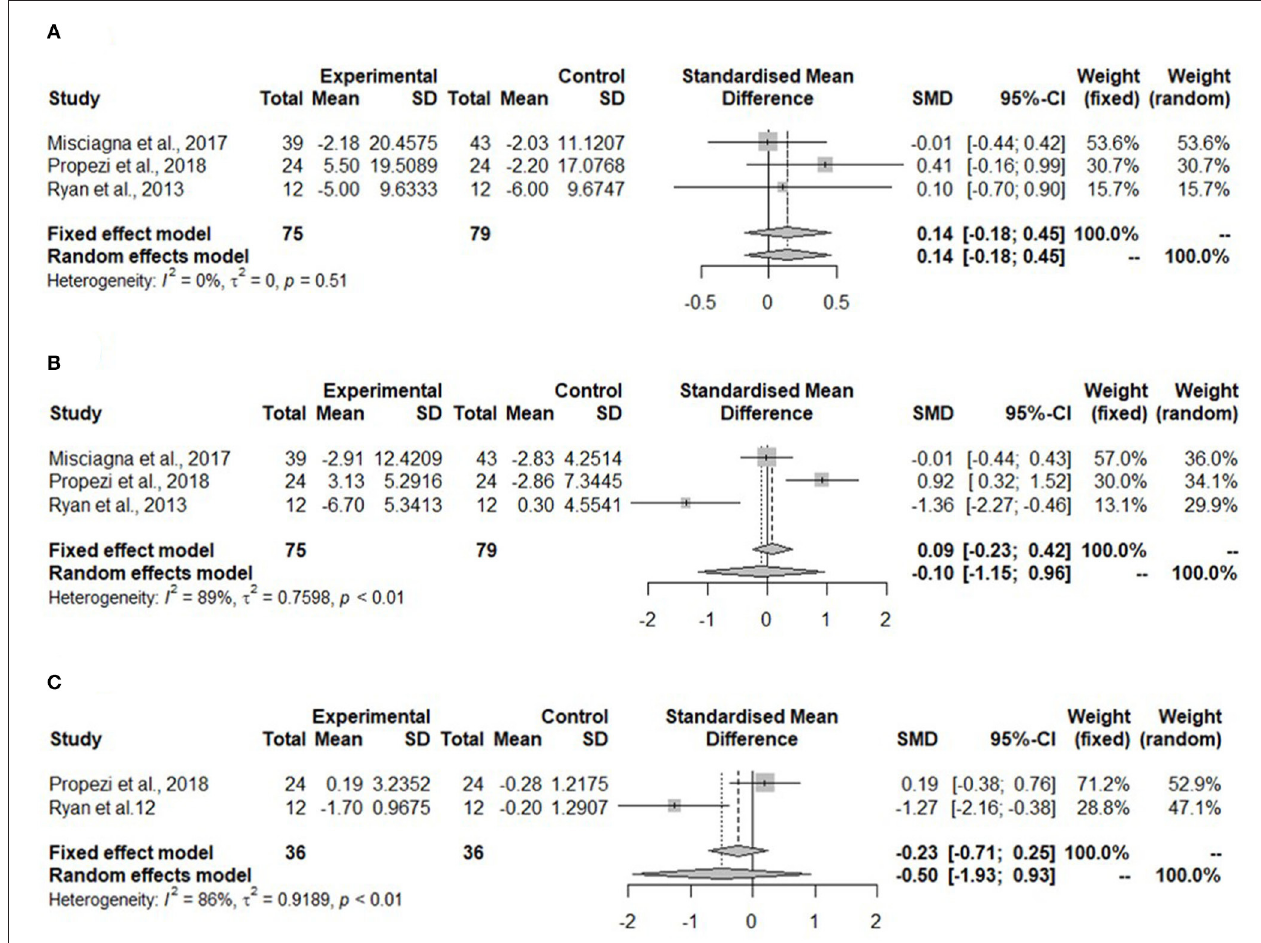
FIGURE 4 | Forest plots of (A) fasting glucose in isocaloric diet; (B) fasting insulin in isocaloric diet; (C) homeostatic model assessment for insulin resistance (HOMA-IR) in isocaloric diet; SD, standard deviation; SMD, standardized mean difference.